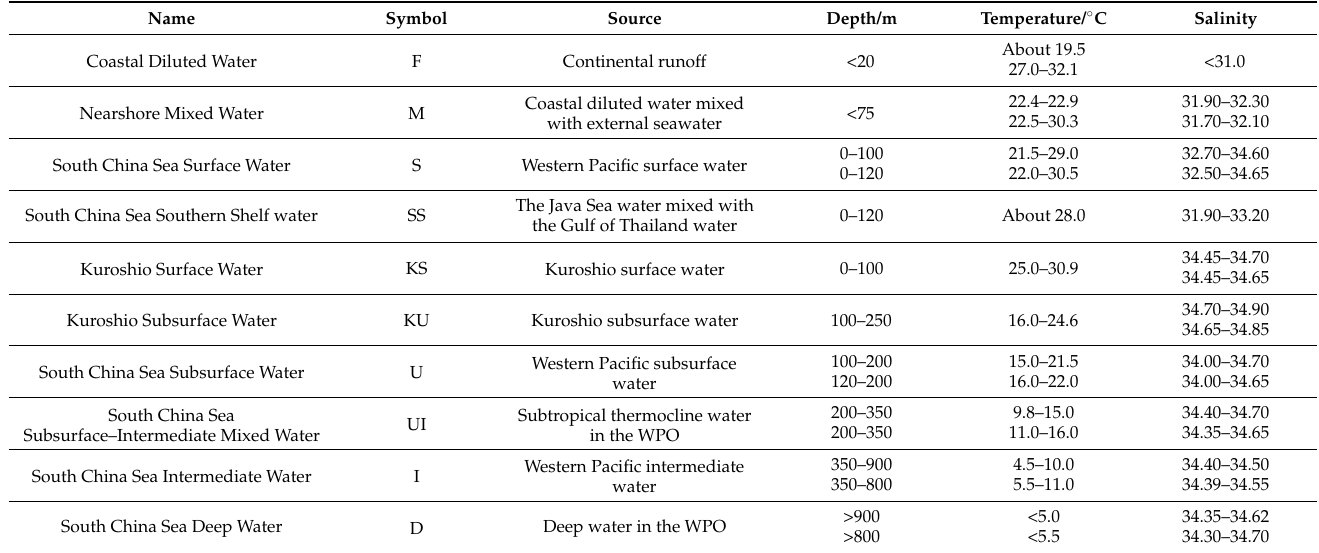
Table 1. Details of each water